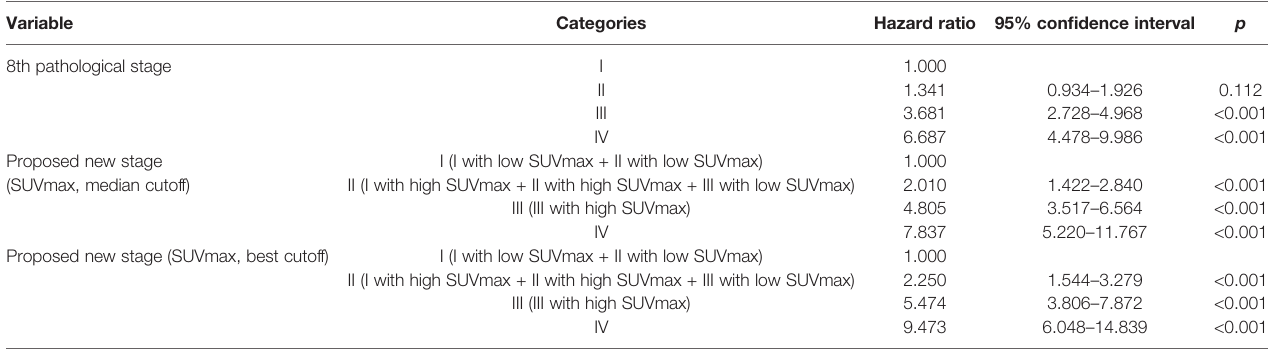
TABLE 5 | Univariate Cox regression analysis of overall survival according to the conventional stage and the proposed new stage including SUVmax in esophageal squamous cell carcinoma.